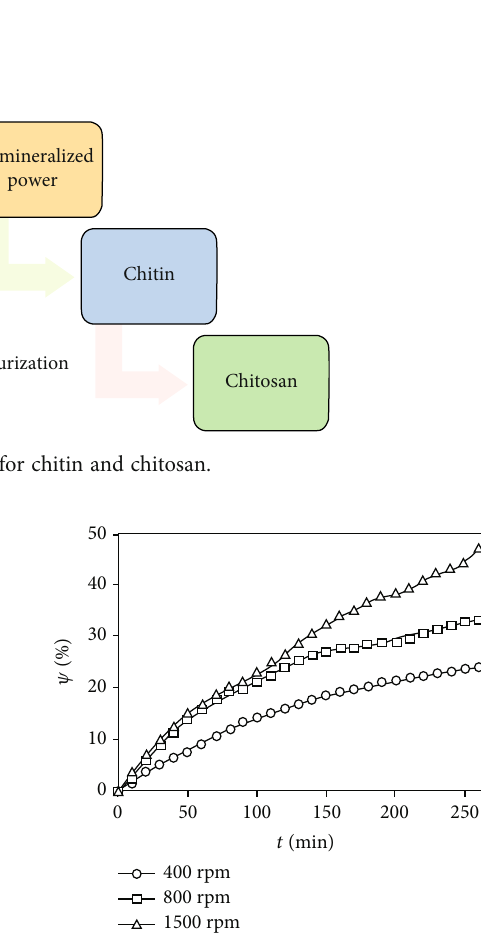
Figure 17: Time courses for citronella oil (0.5 wt%) release from chitosan microcapsules prepared at varying emulsion stirring rates